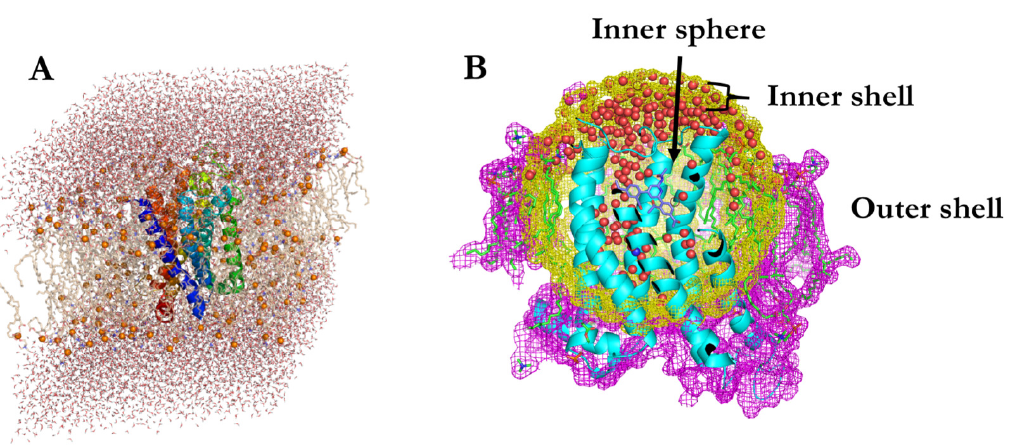
Figure 3. ( A ) The initial system in a triclinic box with 1-palmitoyl-2-oleoyl-sn-glycero-3- phosphocholine (POPC) membrane and water. ( B ) The same system under spherical boundary conditions. Outer shell is in magenta (atoms > 2.7 nm from the centre of geometry (COG) of the ligand), inner shell in yellow (atoms 2.2–2.7 nm from COG ligand) and the inner sphere without surface representation (atoms < 2.2 nm from COG ligand). Ligand is in light purple, the sodium ion in blue, water oxygens in red.